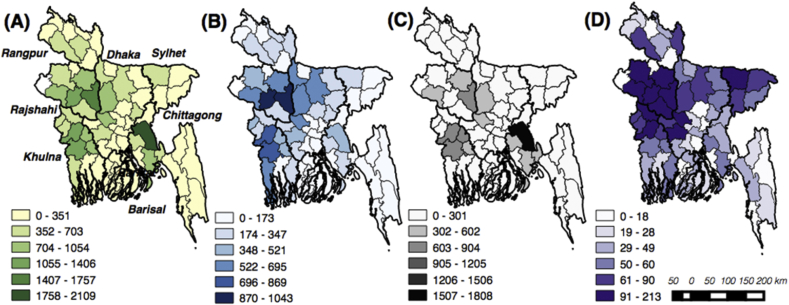
Agricultural machinery ownership by the sampled farm households in Bangladesh. Number of households reporting ownership of: (A) any of the three machine types (survey respondent owns at least one of machine types B-D), (B) irrigation pumps, (C) threshers, and (D) power tillers. Data indicate number of households in each administrative District (separated by thin black lines) reporting machinery ownership in the census survey. Names in (A) reflect administrative Divisions (thick black lines). Data source: BBS (2010).